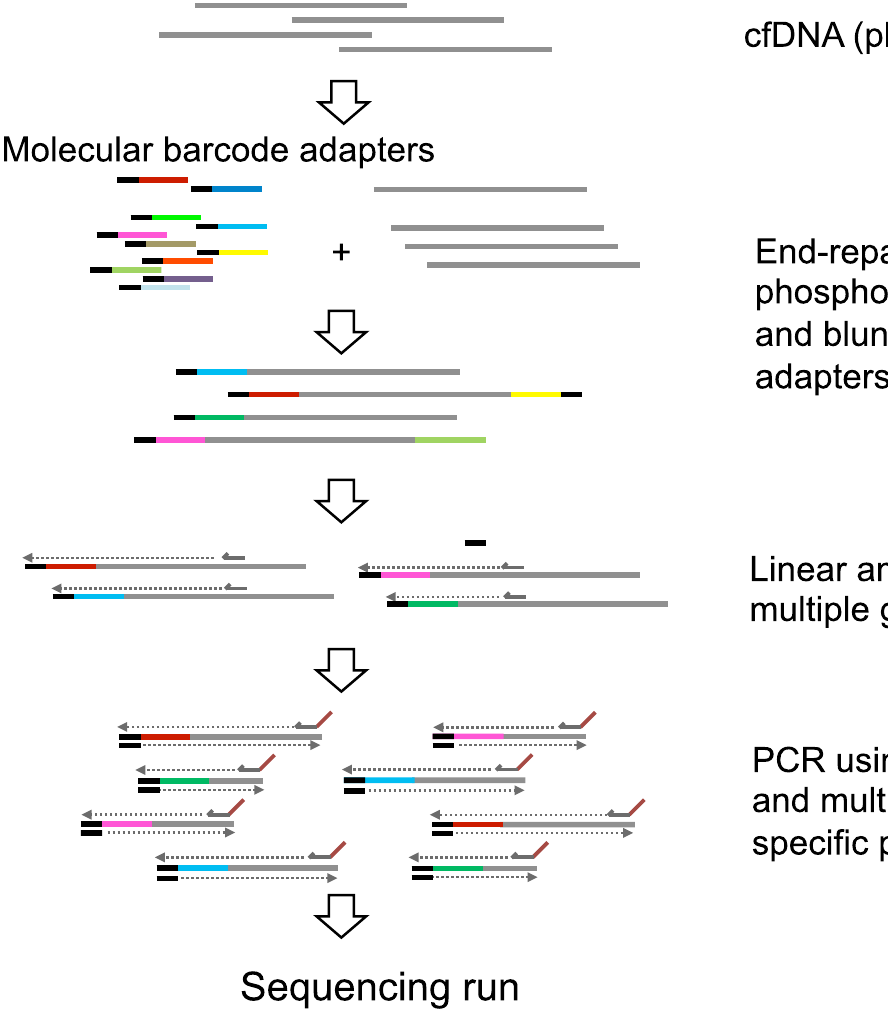
Fig 1. Construction of the molecular barcode library, generated using a revised version of non-overlapping integrated read sequencing system (NOIR-SS). Cell-free DNA is end-repaired, phosphorylated and ligated to adapters including barcode sequences. DNA fragments with the adapters are subjected to linear amplification using multiple gene-specific primers. To construct sequencing libraries, the products are subjected to PCR using primers including sequences indispensable for the Ion Torrent sequencer.